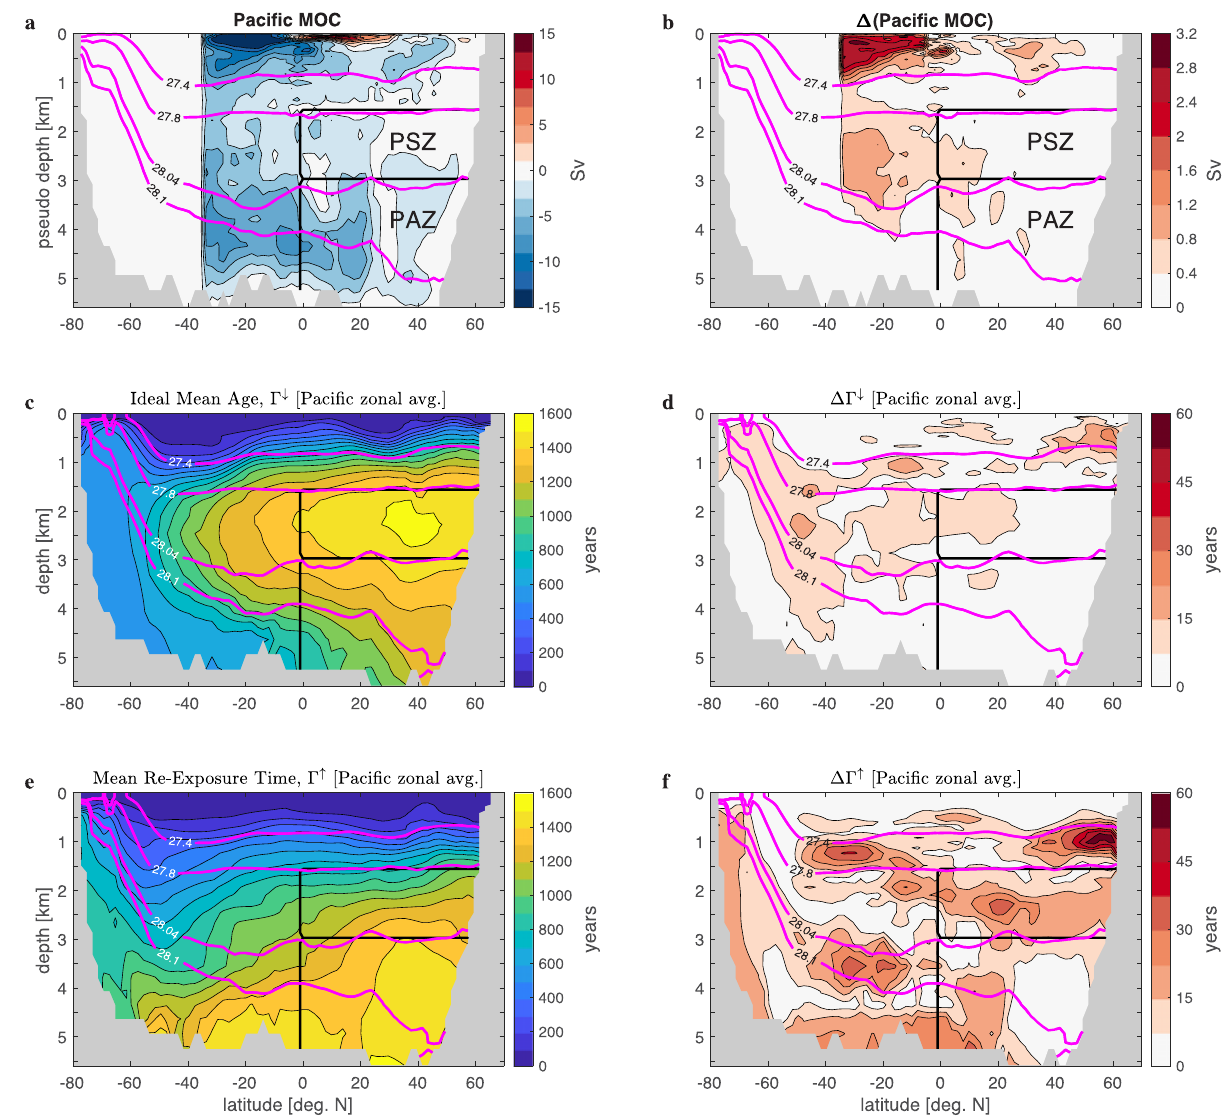
Fig. 2 Paci fi c meridional overturning stream function, ideal mean age, and mean re-exposure time. Stream function of the Paci fi c meridional overturning circulation (MOC) computed from the meridional fl ow below a given neutral density and remapped to a pseudo depth 32 for the Paci fi c ( a ) and its half- range Δ ( b ) over the three states considered. Paci fi c zonal averages of the mean time since last surface contact (ideal mean age, Γ ↓ ) ( c ) and the mean time to next surface contact (mean re-exposure time, Γ ↑ ) ( e ), and their half-ranges ΔΓ ↓ ( d ) and ΔΓ ↑ ( f ). The heavy black lines delineate the Paci fi c Shadow Zone (PSZ) and the Paci fi c Abyssal Zone (PAZ) beneath. Because the North Paci fi c between 1500 and 3000 m depth is characterized by both weak overturning and the oldest ideal mean ages, we de fi ne both the PSZ and PAZ to lie in the North Paci fi c bounded to the south by the equator. The magenta lines indicate zonal mean neutral density surfaces (contour labels in units of kg m − 3